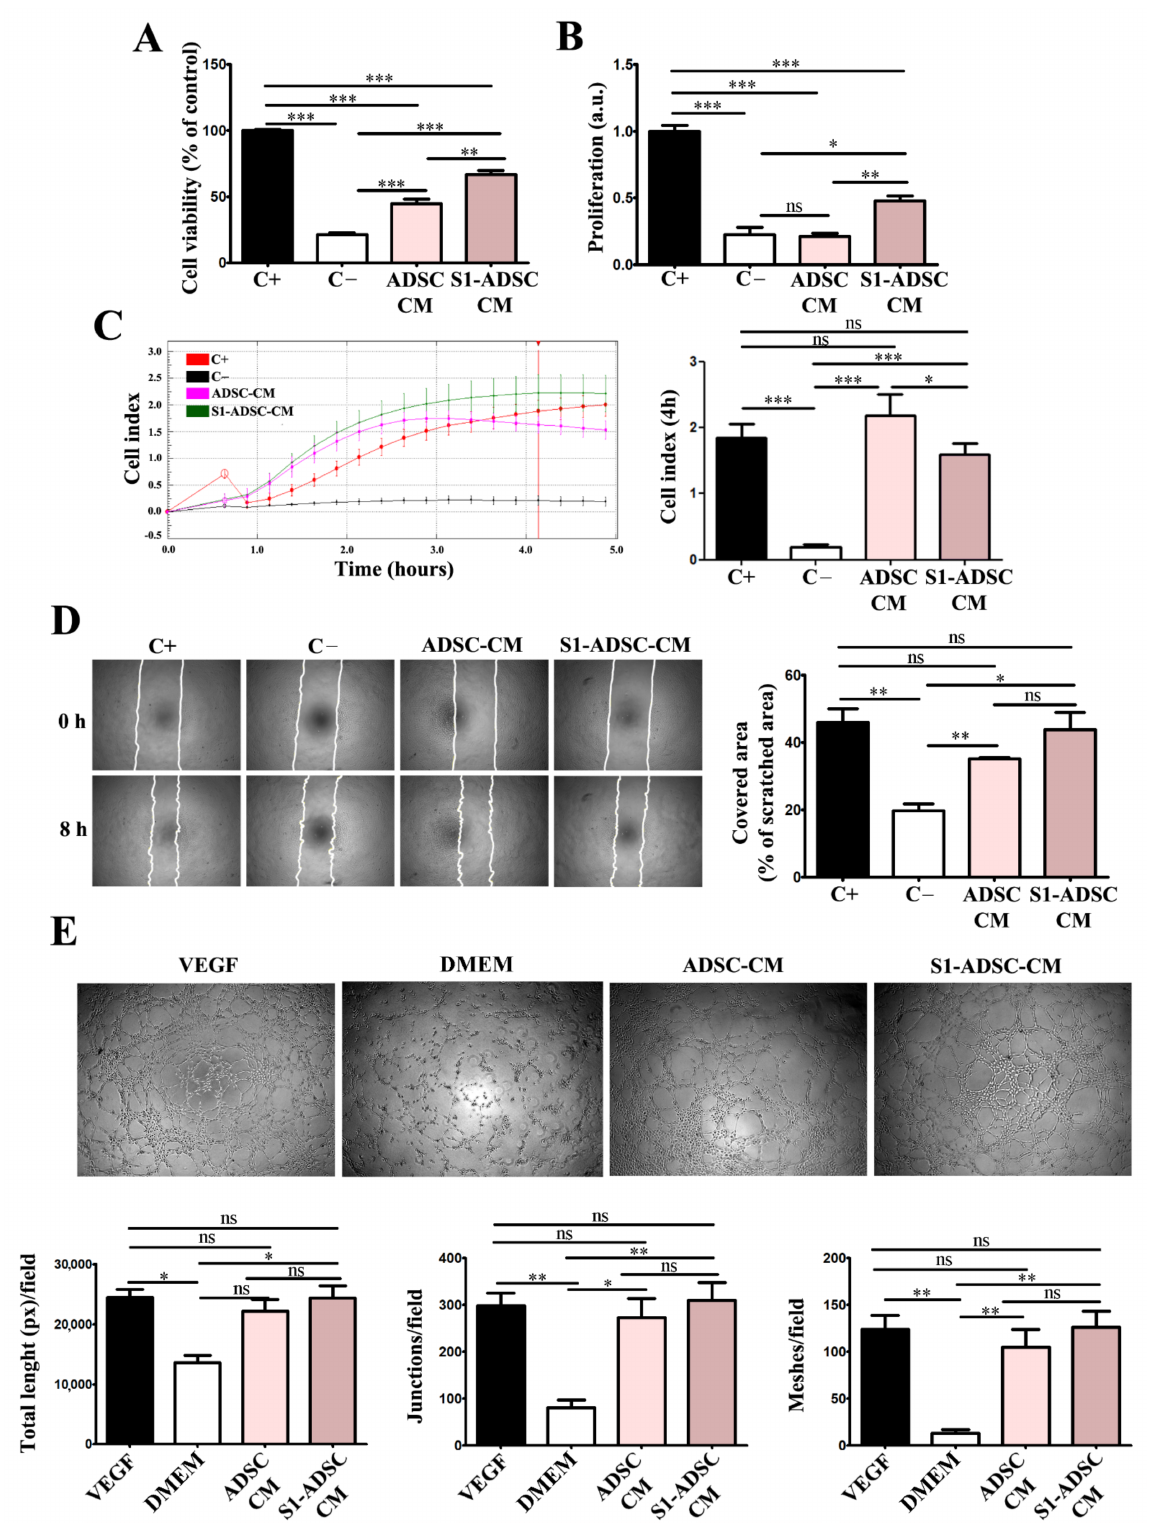
Figure 6. Assessment of pro-angiogenic effect of hTERT S1-ADSC-CM versus ADSC-CM on human EC. ( A ) Viability of EC cultured for 5 days in the presence of hTERT S1-ADSC-CM versus ADSC-CM as revealed by XTT assay; ( B ) Assessment of hTERT S1-ADSC-CM versus ADSC-CM potential to promote EC proliferation as revealed by DNA quantification; ( C ) Time-dependent chemotactic